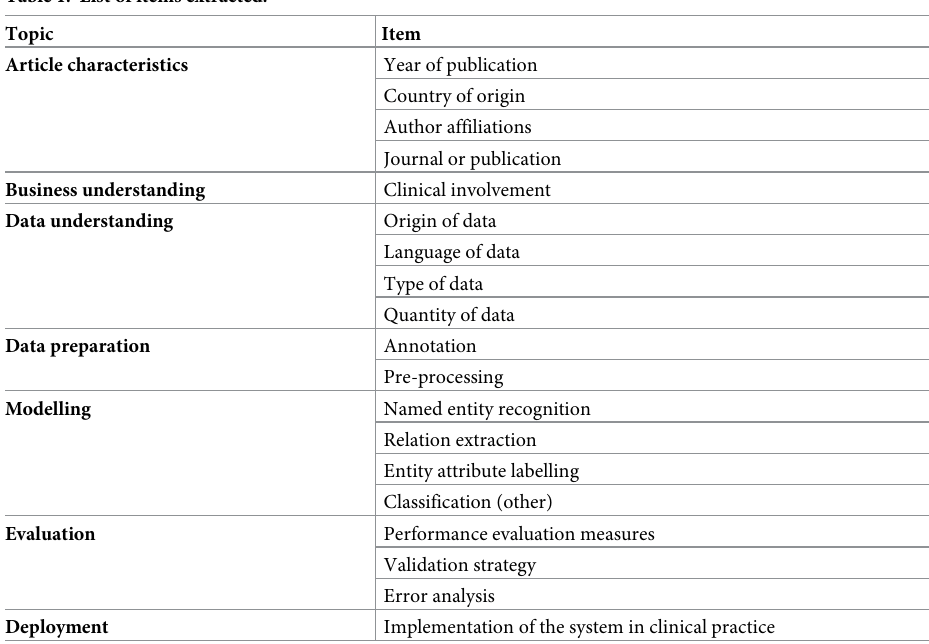
Table 1. List of items